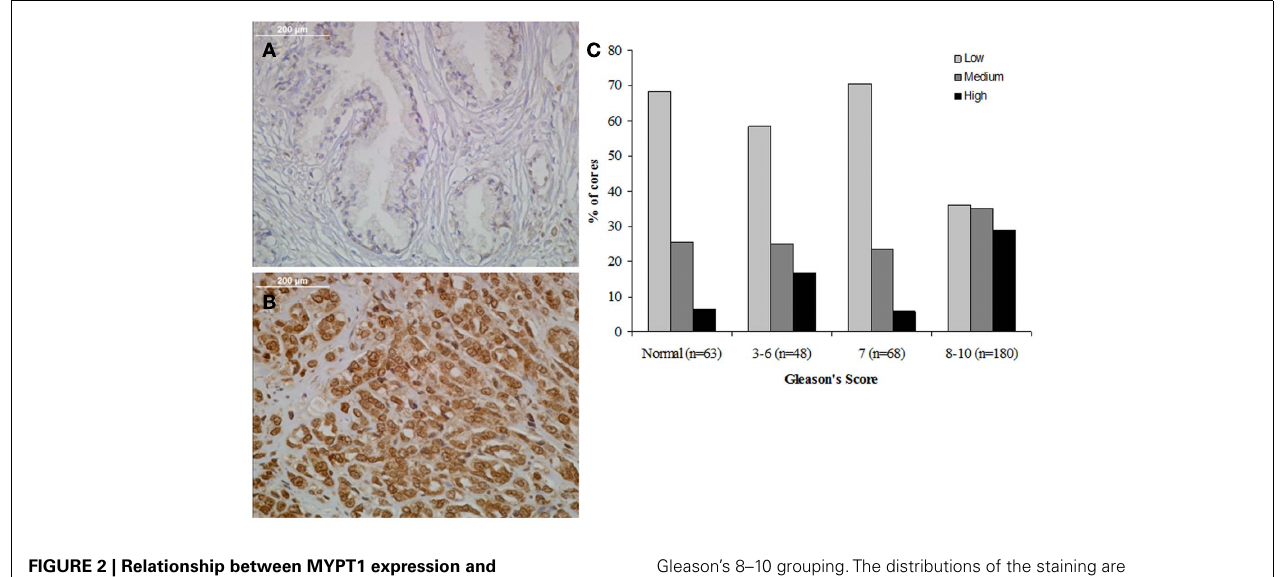
FIGURE 2 | Relationship between MYPT1 expression and Gleason’s score. (A) Representative staining of benign human prostate tissue. (B) Representative staining of poorly differentiated human prostate cancer. (C) EachTMA core’s staining was graded and tabulated in comparison to groupings of Gleason’s scores (normal, 3–6, 7, and 8–10). MYPT1 staining was seen in increased levels in the